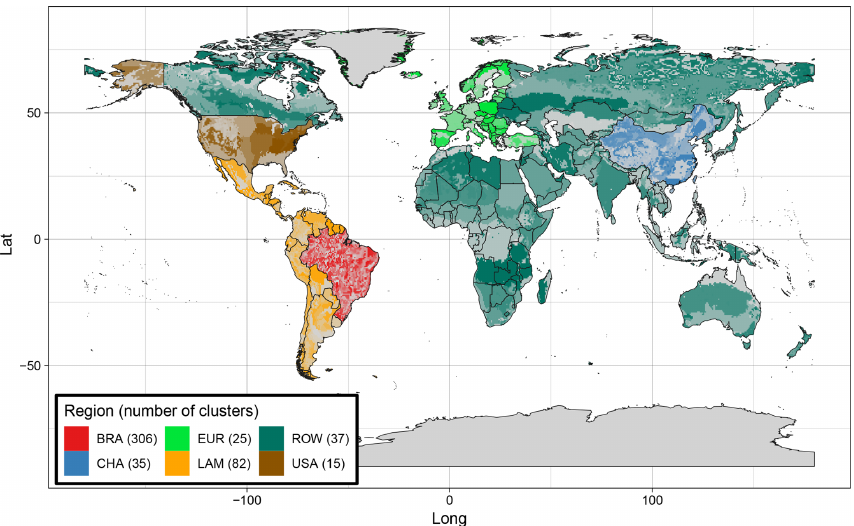
Figure 4. Study setup tailored to assessments with a focus on Brazil, with six world regions and 500 clusters: Brazil (BRA) in increased spatial resolution, its major trade partners Latin America (LAM), United States (USA), China (CHA) and Europe (EUR) in default resolution and the rest of the world (ROW) combined to one region with reduced